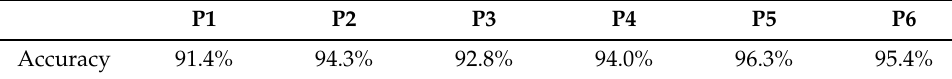
Table 8. Vital sign monitoring accuracies for six